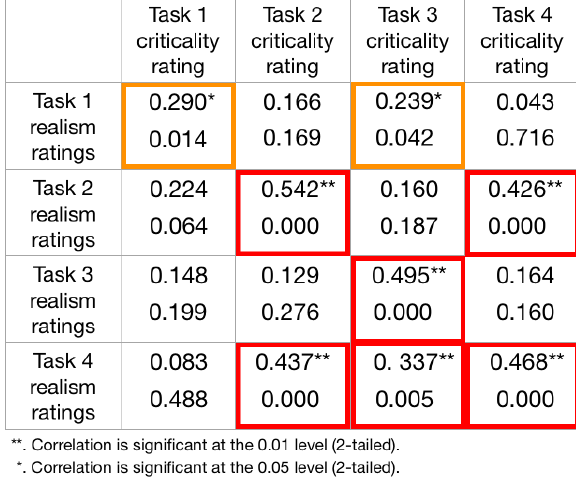
Figure 22: Correlation table between ratings of task criticality and task